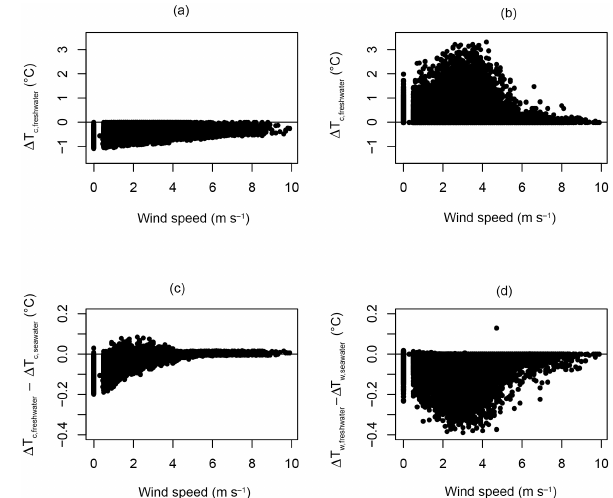
Figure 4. Cool skin (a) and warm layer (b) effect estimated by the model proposed by Fairall et al. (1996a) using the data for Bimont, and the difference in cool skin (c) and warm skin (d) effect between freshwater (salinity = 0gkg − 1 ) and seawater (35gkg − 1 ) according to the same model and meteorological